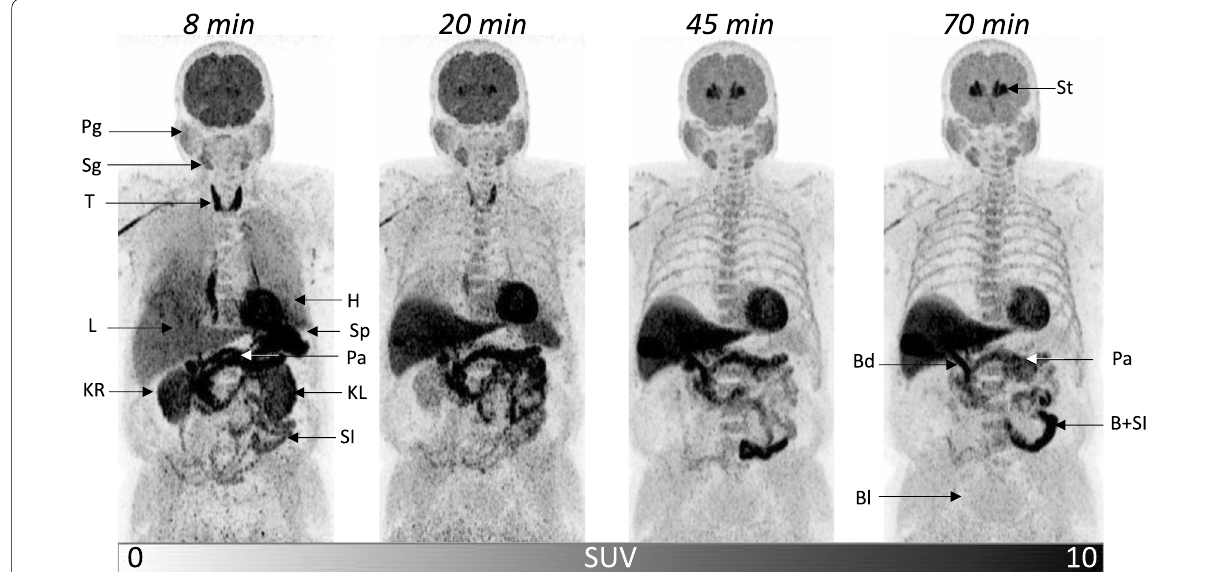
Fig. 2 Maximum intensity projection images of whole-body [ 18 F]FEOBV distribution at 8, 20, 45, and 70 min post injection. Bd, bile duct; Bl, urinary bladder; B SI, bile in small intestine; H, heart; KL, left kidney; KR, right kidney; L, liver; Pa, pancreas; Pg, parotid gland; Sg, submandibular gland; SI, + small intestine; Sp, spleen; St, striatum; T,